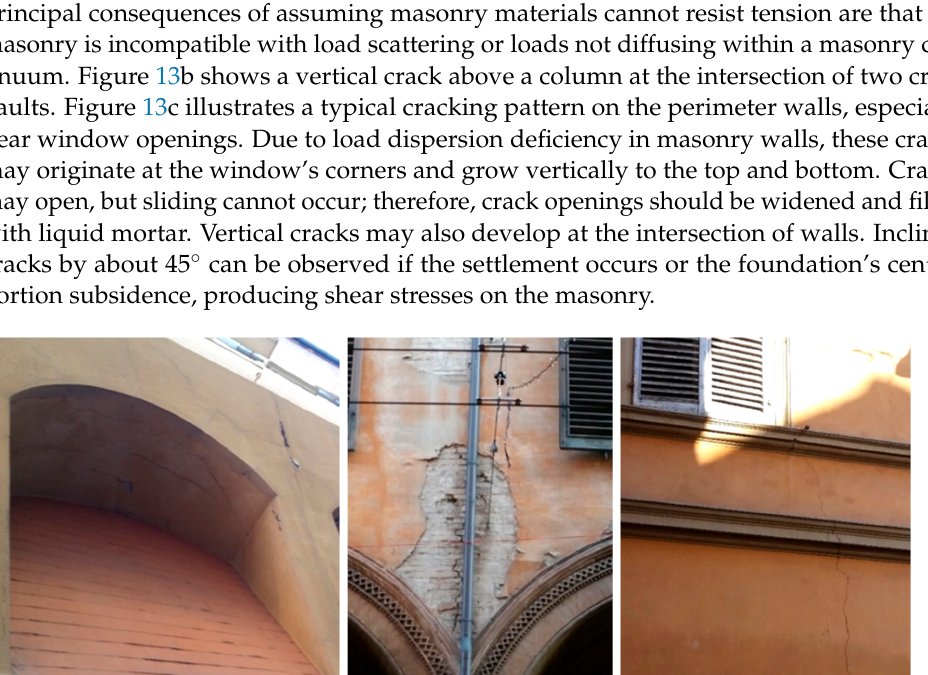
Figure 12. ( a ) A coupled system of cross vaults reinforced by steel tie rods; ( b ) reinforcement by steel tie-rod and bar-shaped anchor plate, Bologna, Italy. tie-rod and bar-shaped anchor plate, Bologna, Italy.